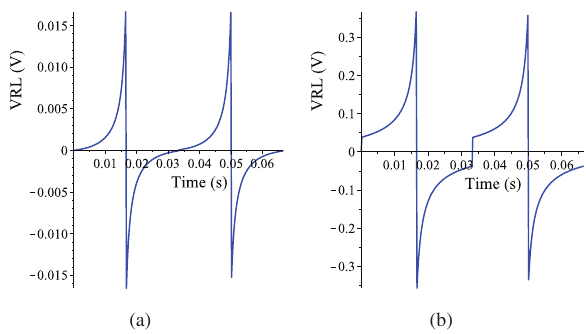
Fig. 8 : Output voltage of the memristor bridge dependent on time. Input voltage is a synaptic impulse as shown in Fig. 7 with e = 0 . 23 . Initial states of this cell: (a) e = 0 , (b) e = 0 . 23